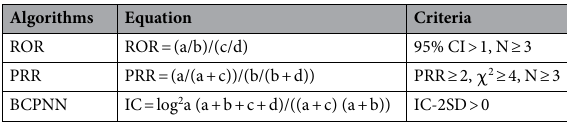
Table 8. Summary of major algorithms used for signal